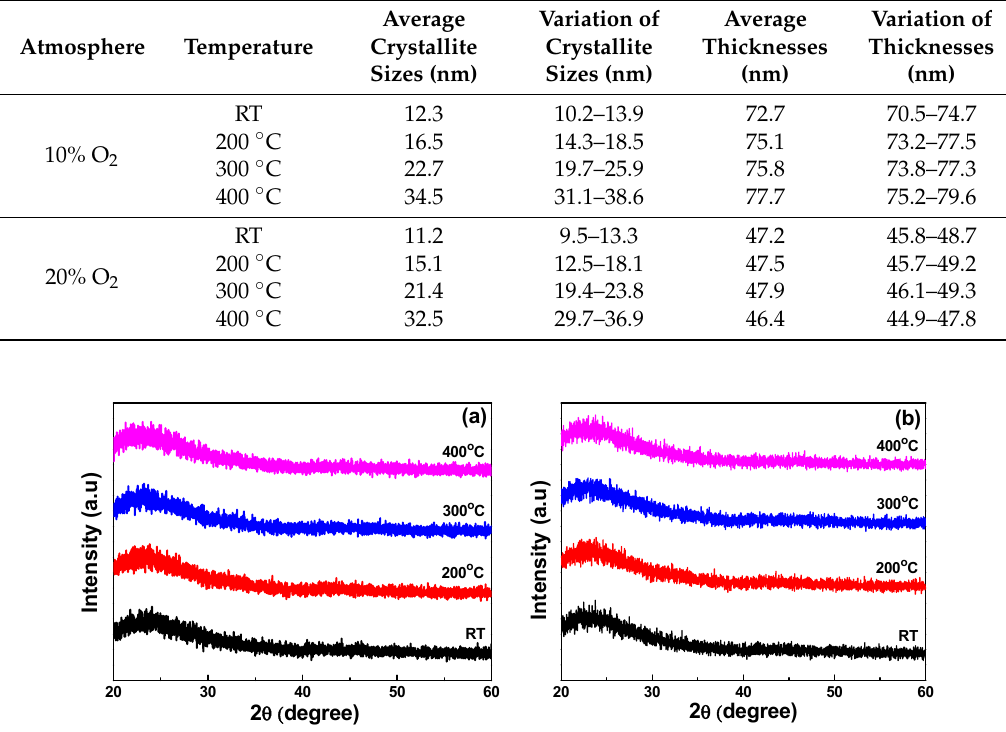
Figure 2. X-ray diffraction (XRD) patterns of Nb 2 O 5 thin films as a function of deposition temperature and O 2 ratio. ( a ) O 2 ratio 10% and ( b ) O 2 ratio 20%, respectively.